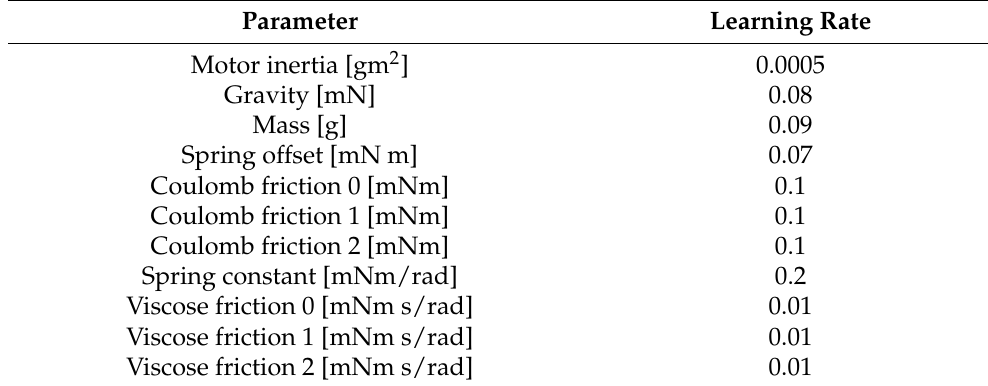
Table 1. Parameters and the corresponding learning